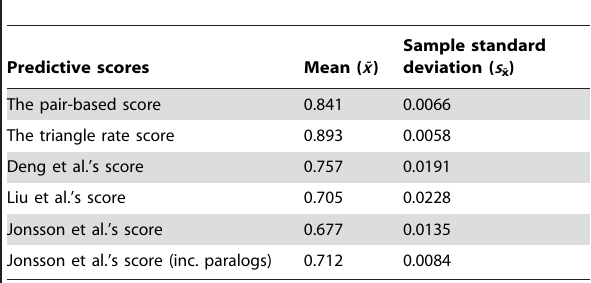
Table 3. Areas under ROC Curves for Scores Comparison.